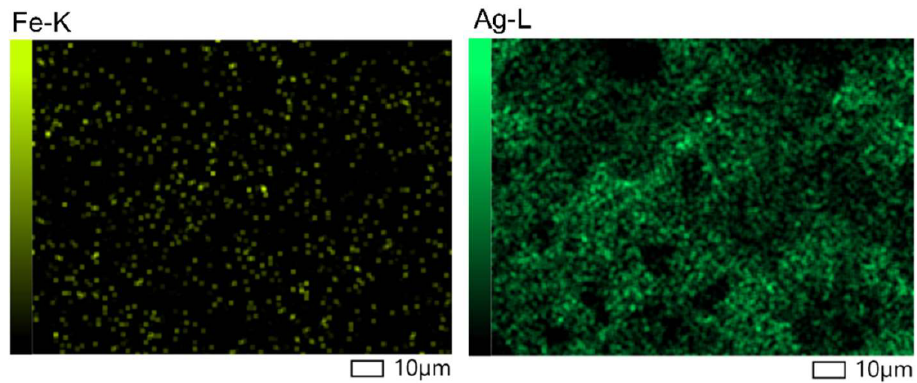
Figure 7. SEM image and X-ray mapping for ( a , a’ ) Fe 3 O 4 @Chitosan-AgNPs (0.2) and ( b , b’ )